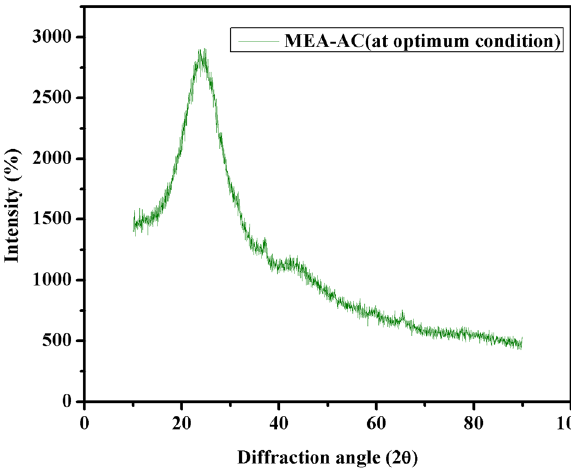
Fig. 14 XRD Analysis of MEA-AC (at optimum